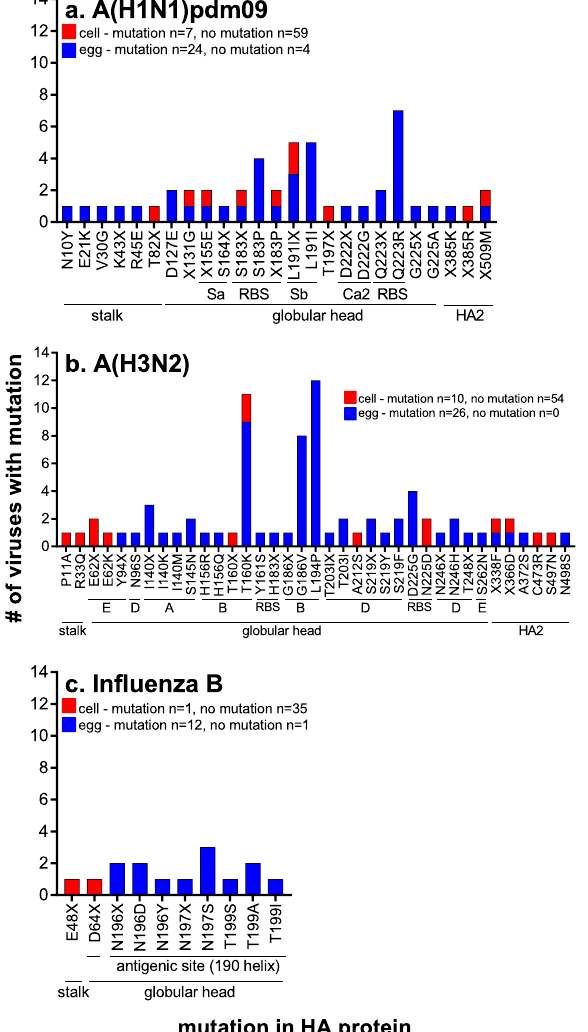
Fig. 6 Assessment of mutations in the HA protein following virus isolation. The frequency of mutations in HA protein of viruses isolated in cells and eggs for A(H1N1)pdm09 ( a ), A(H3N2) ( b ), B/ Victoria and B/Yamagata ( c ) as compared to the OCS. The total number of cell and egg virus isolates with HA gene sequenced and the number of viruses with and without any mutation in the HA is indicated on each graph. The location of each mutation in the HA protein is indicated below the x-axis, as determined using 26,58 – 60 .